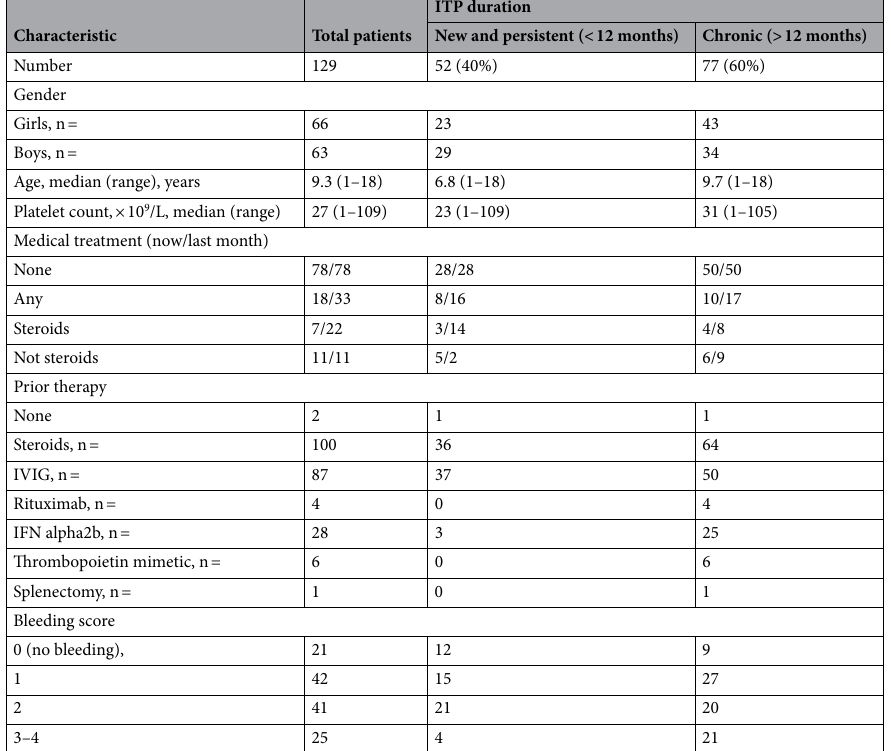
Table 1. Patient characteristics not on